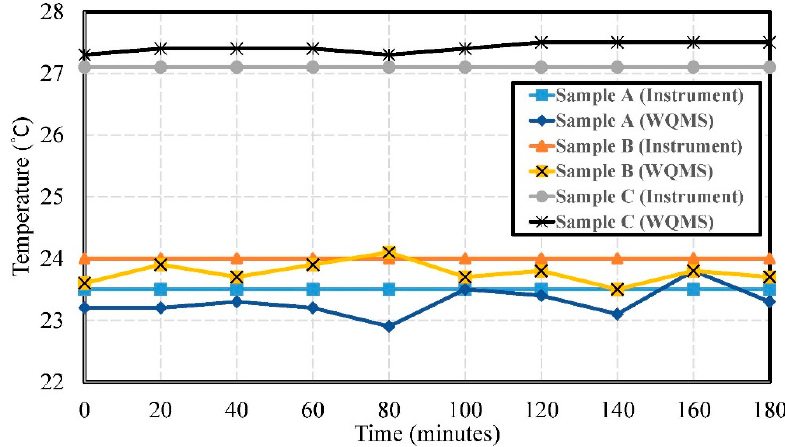
Figure 6. The experimental results of the temperature by using Samples A, B, and C.